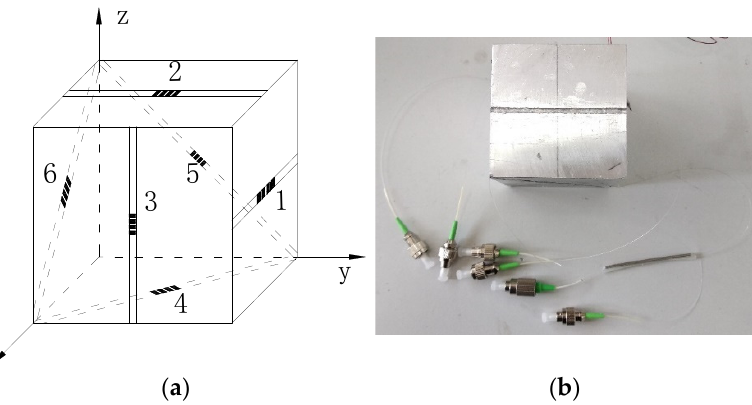
Figure 4. Structure diagram of FBG three-dimensional stress sensor. ( a ) Layout diagram of FBG; ( b ) Physical drawing of the sensor.